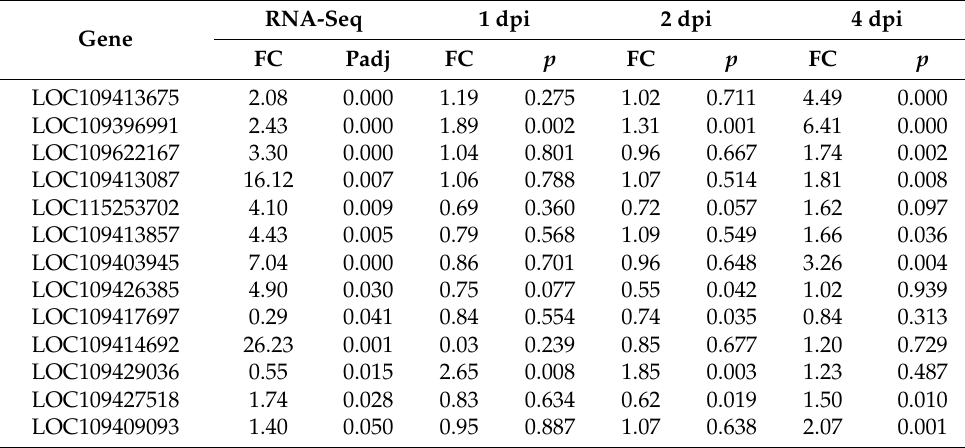
Table 2. The expression levels of 13 genes at 1, 2, and 4 dpi.